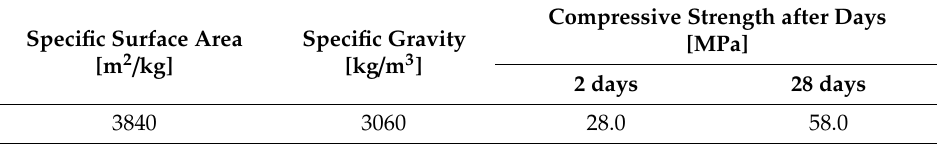
Table 2. Physical properties of cement